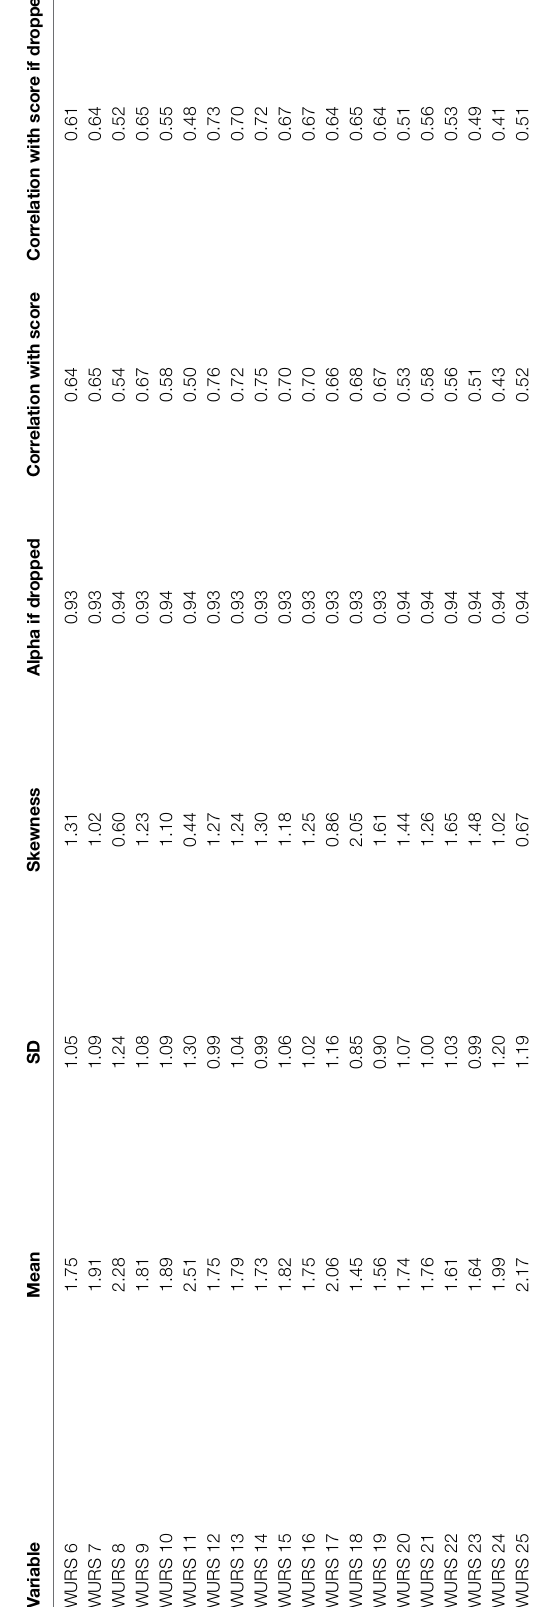
TABLE 3 | Cronbach’s alpha and omega total for each of the scales.